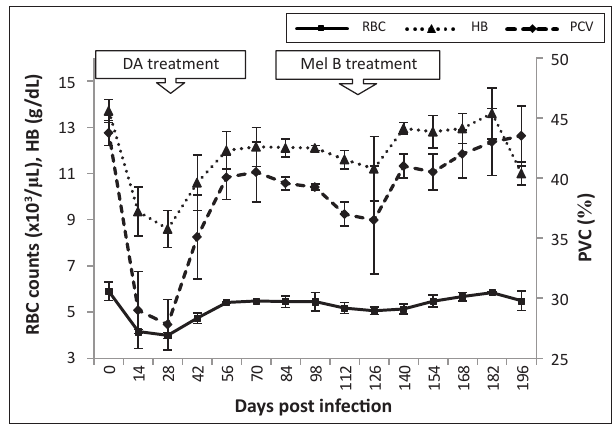
FIGURE 3 : Mean changes in red blood cell (RBC) counts, packed cell volume (PCV) and haemoglobin (HB) of vervet monkeys infected with T. b. brucei GUTat 1, showing the point of subcurative treatment with diminazene aceturate (DA) (28 dpi) and curative treatment with melarsoprol (Mel B) (119 dpi).